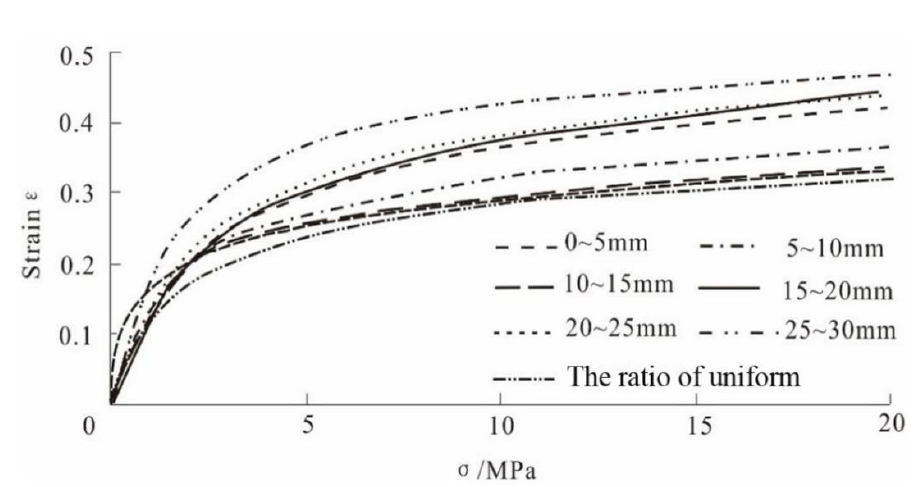
Figure 28. Consolidation curves of gangue with different grain gradations [106].